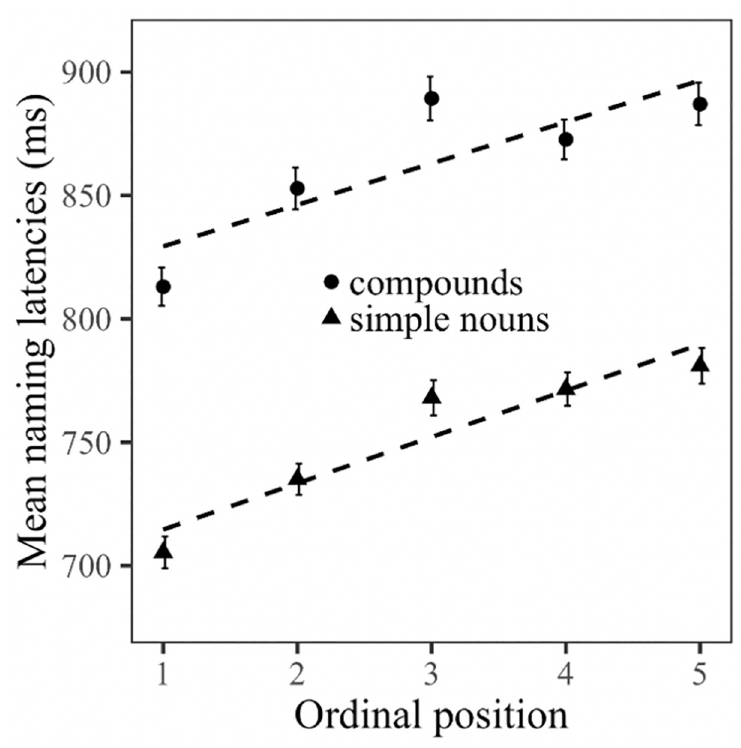
Fig 1. Mean reaction times (naming latency) and standard error (in milliseconds) observed in Experiment 1 broken down by ordinal position and word type.